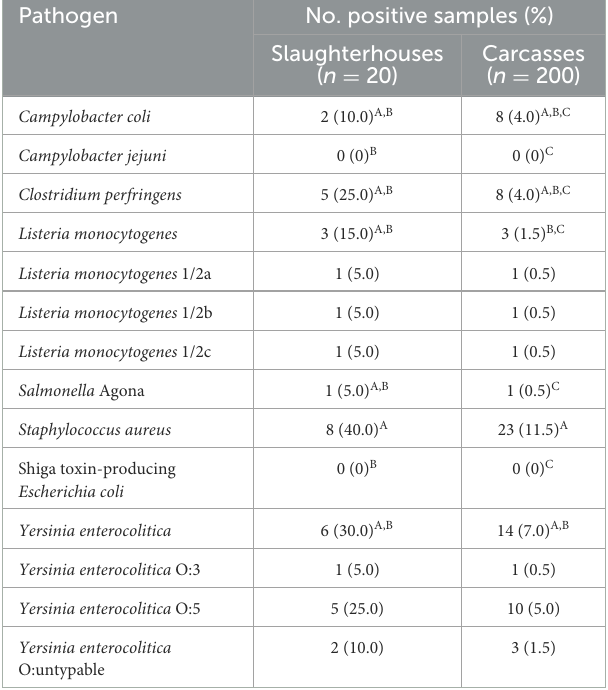
TABLE 3 Prevalence of foodborne pathogens in pig slaughterhouses and